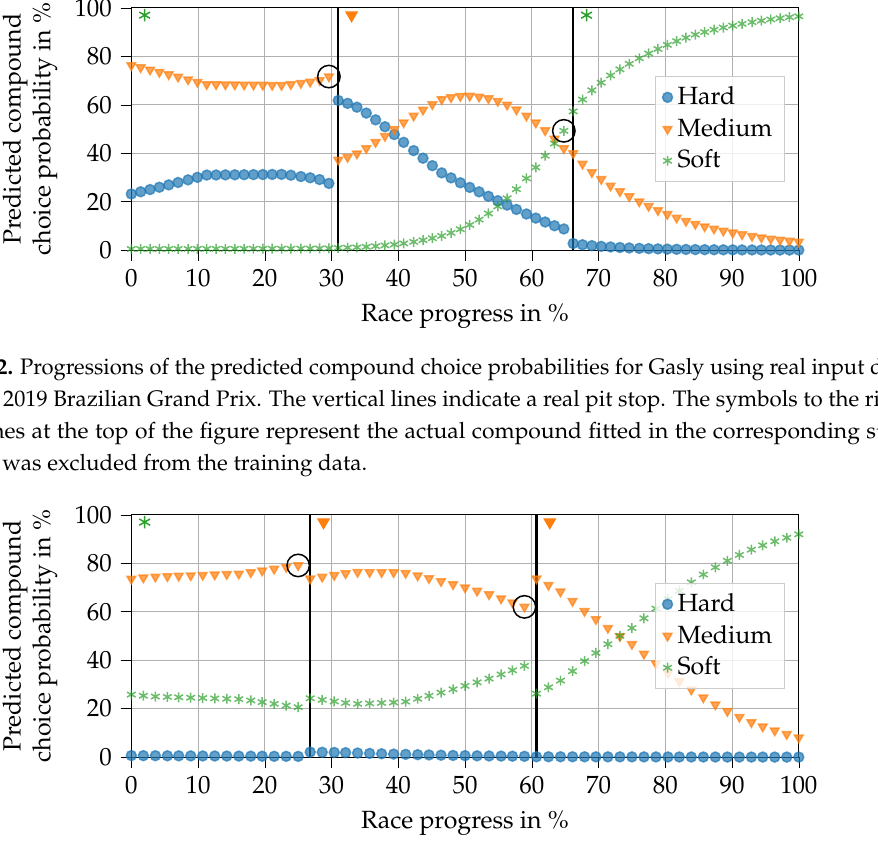
Figure 13. Progressions of the predicted compound choice probabilities for Rosberg using real input data from the 2014 United States Grand Prix. The vertical lines indicate a real pit stop. The symbols to the right of the lines at the top of the figure represent the actual compound fitted in the corresponding stint. The race was excluded from the training data.